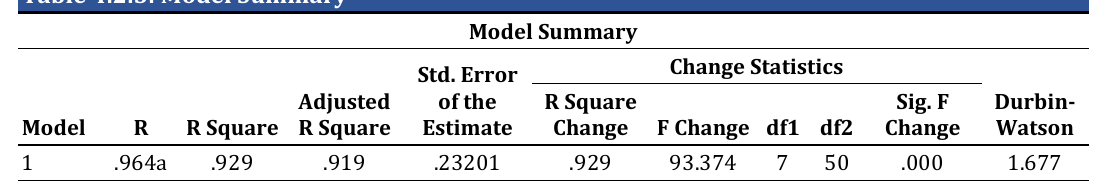
Table 4.2.5: Model Summary